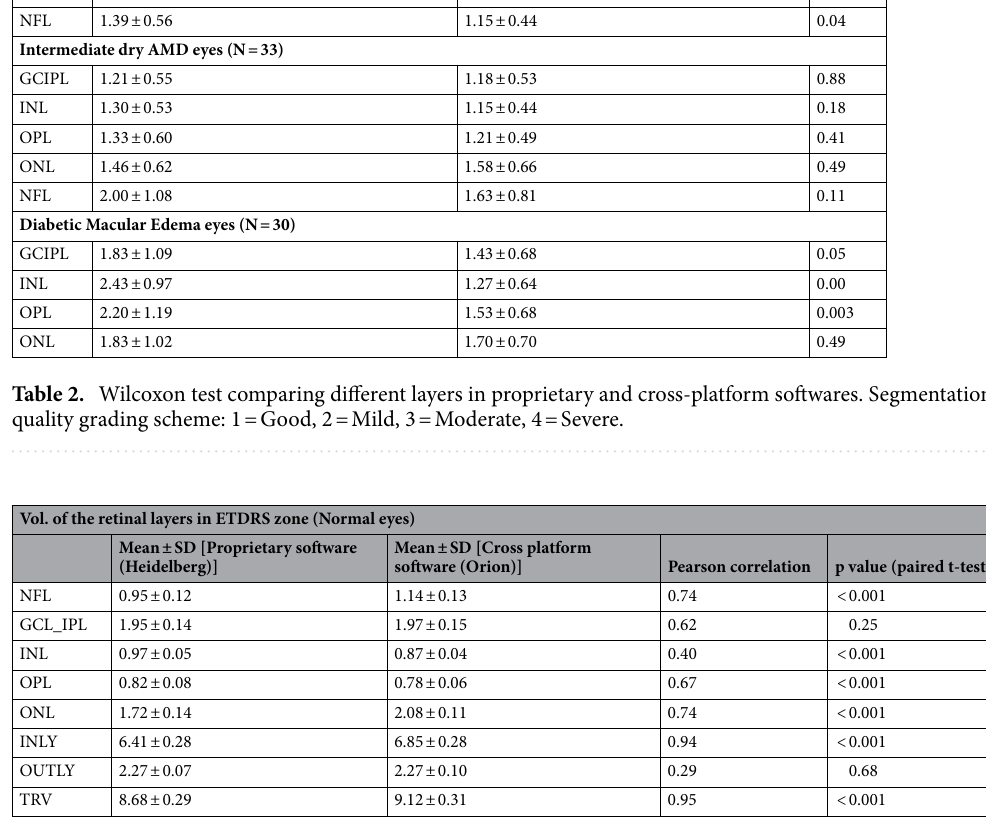
Table 3. Layer volume data in normal eyes from the proprietary and the cross-platform softwares.